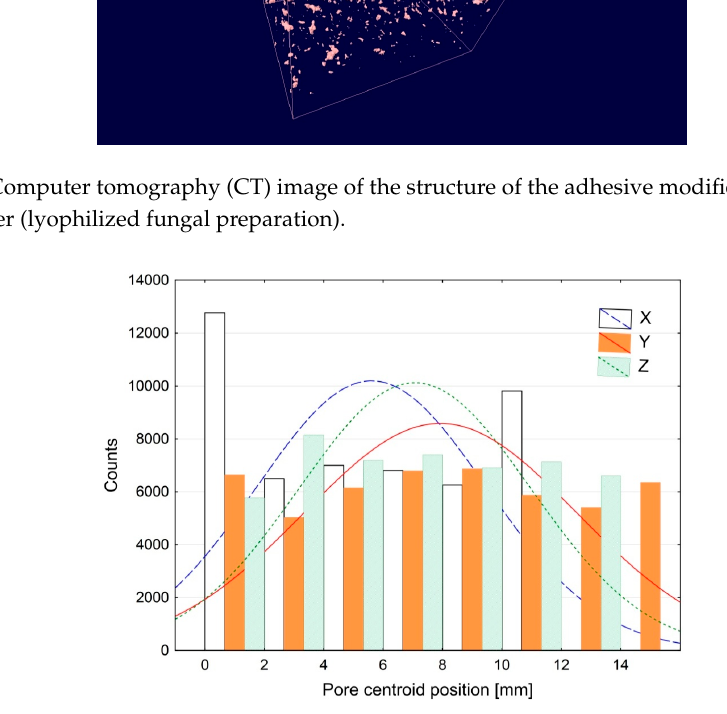
Figure 5. Histogram of the coordinate distribution describing the location of pores in the adhesive modified with 0.50% of the modifier (lyophilized fungal preparation).